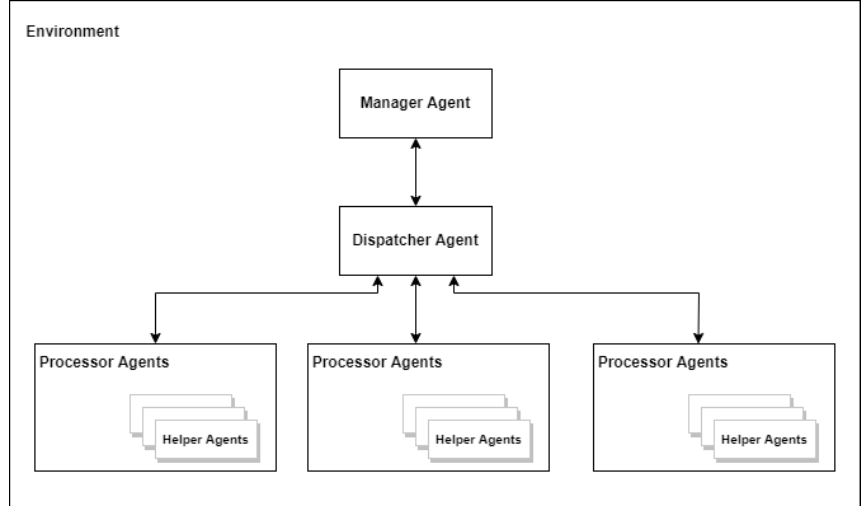
Figure 1. The main agents of the